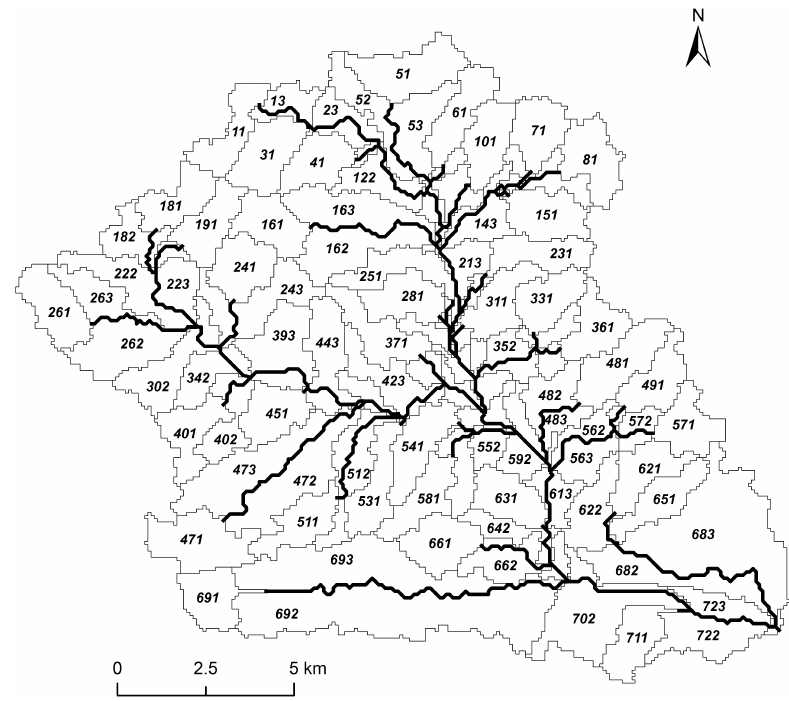
Figure 2. Planes for the Agoufou watershed with the DEM-derived drainage network. Table 3. Summary of hydrological parameters for each landscape unit, sorted by increasing infiltration (Ks: saturated hydraulic conductivity; POR: soil porosity; G: capillary charge saturation; DIST: pore distribution; FR: fraction of sand, silt and clay; THICK: upper soil thickness; n/a: not applicable).